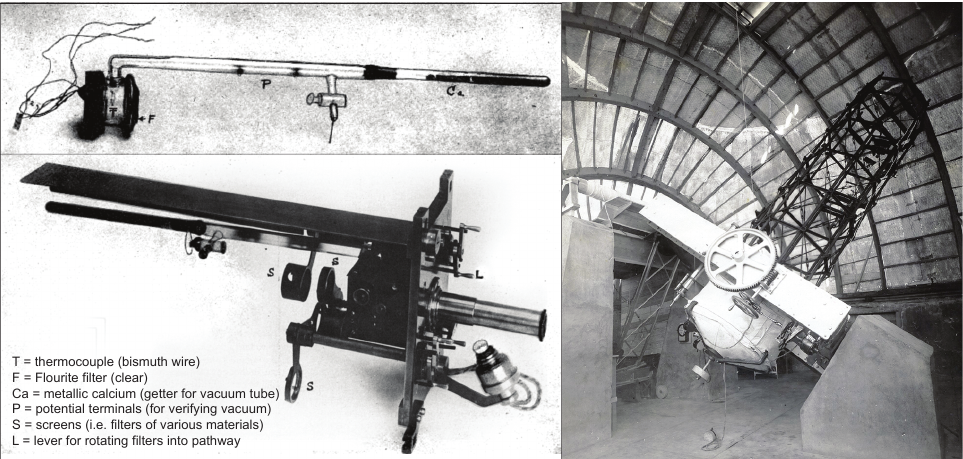
Figure 5. Photographs of the Coblentz-Lampland radiometer, used to make groundbreaking mea- surements of thermal from stars and the giant planets [115]. Top left: Evacuated glass tube containing the thermocouple—a wire of bismuth that converts temperature differences to electric voltage via the thermoelectric effect. The thermocouple is kept in an evacuated tube, with the vacuum maintained by the presence of reactive calcium metal (serving as a getter). Bottom left: The thermocouple is placed into the radiometer, which was fastened to the photographic plate holder of the telescope. The thermocouple was placed in the optical path between the target and eyepiece, while filters of different passbands were selectively rotated in and out of view. By these means, coarse spectra could be inferred. Right: The Lampland 40-inch telescope of the Lowell Observatory, on which the radiometer was mounted for much of Coblentz’s planetary work, inside its dome, ca. 1909 ( Image credit: Slipher, E.C., “The 42-inch Lampland Telescope inside of its dome,” Lowell Observatory Archives, https://collectionslowellobservatory.omeka.net/items/show/1047 , accessed on 22 December